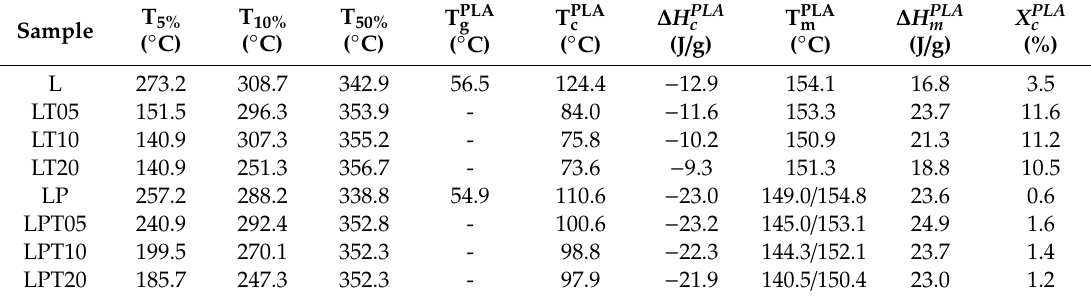
Table 1. Thermal properties of PLA-based materials.